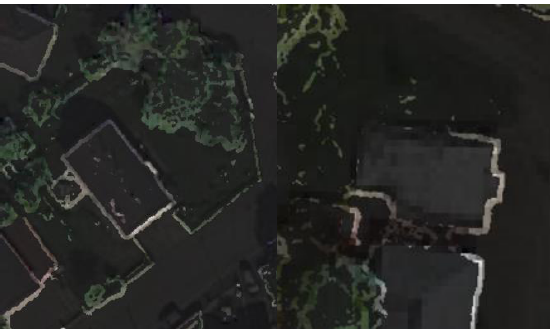
Figure 8. Errors resulting from incorrect division (left: hedges and lawn are not separated, right: slope and rooftop are not separated).